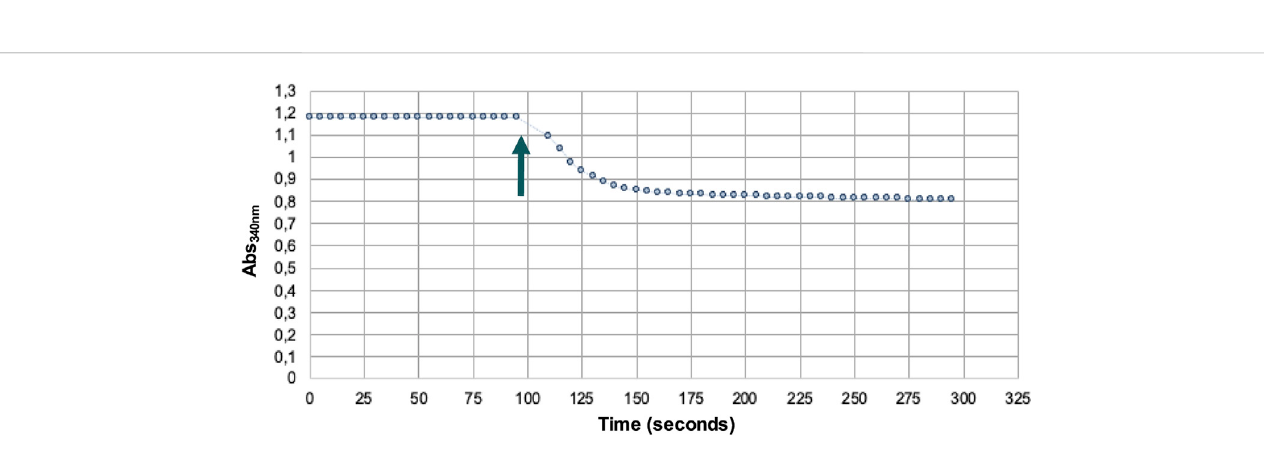
FIGURE 4 Spectrophotometric assay of PAPSS1 activity. Arrow indicates the addition of the substrate K 2 SO 4